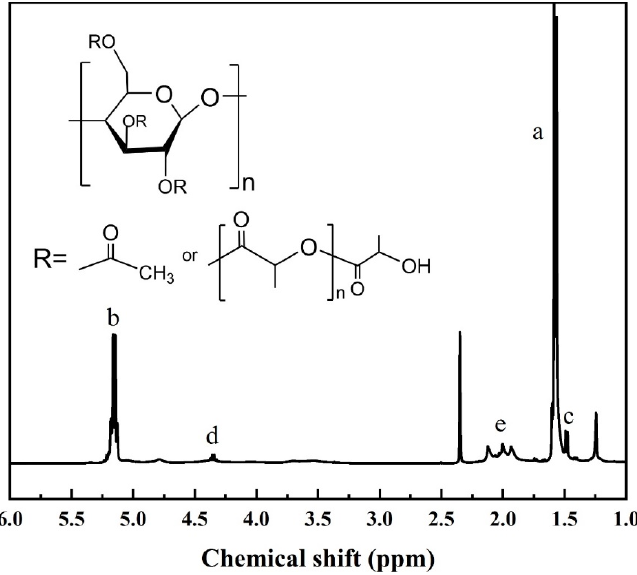
Figure 5. 1 H NMR spectrum and structural formula of CDA − g − PLLA.